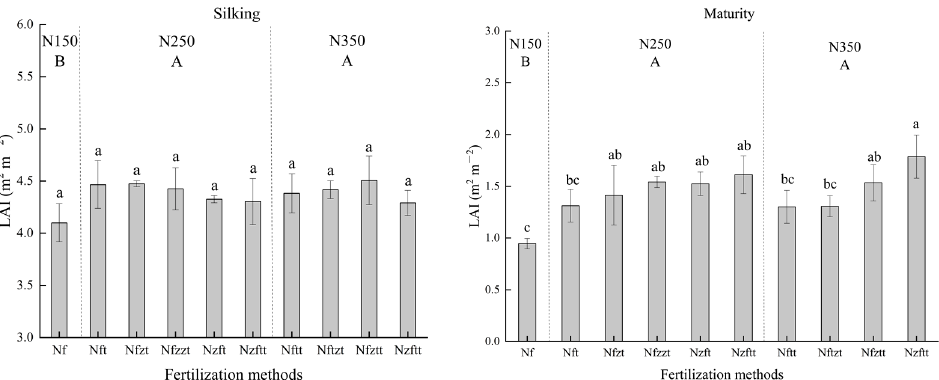
Figure 9. Effects of fertilization methods on leaf area index (LAI) at silking and maturity stages under different nitrogen application rates. N150, N250, and N350 refer to the nitrogen application rate being 150, 250, and 350 kg ha − 1 , respectively. “z” refers to the nitrogen application rate being zero, “f” refers to the nitrogen application rate being 150 kg ha − 1 , “t” refers to the nitrogen application rate being 100 kg ha − 1 , e.g., Nf refers to nitrogen application rate being 150 kg ha − 1 at sowing stage; Nfzt refers to nitrogen application rate being 150, 0, and 100 kg ha − 1 at sowing, 6-leaf, and 12-leaf stages, respectively; Nzftt refers to the nitrogen application rate being 0, 150, 100, and 100 kg ha − 1 at sowing, 6-leaf, 12-leaf, and silking stages, respectively. The data were averaged over 2018 and 2019. Capital letters indicate a significant difference at the p < 0.05 level under different nitrogen application rates. Lowercase letters indicate a significant difference at the p < 0.05 under all treatments.